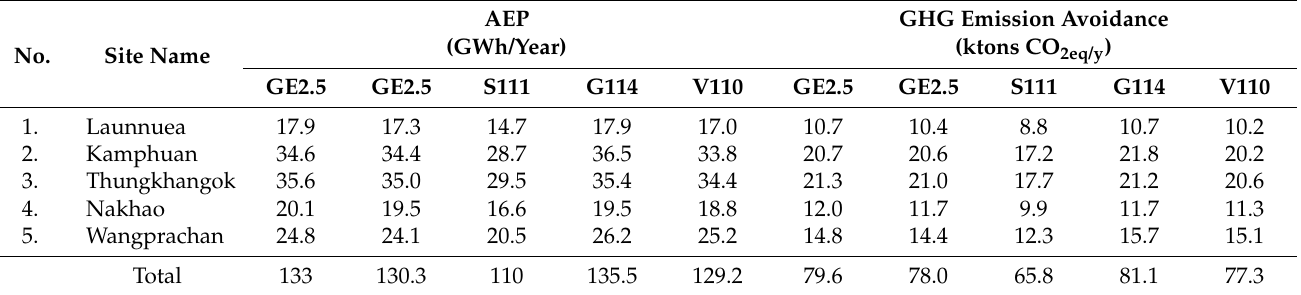
Table 6. AEP and GHG emission avoidances for the five potential